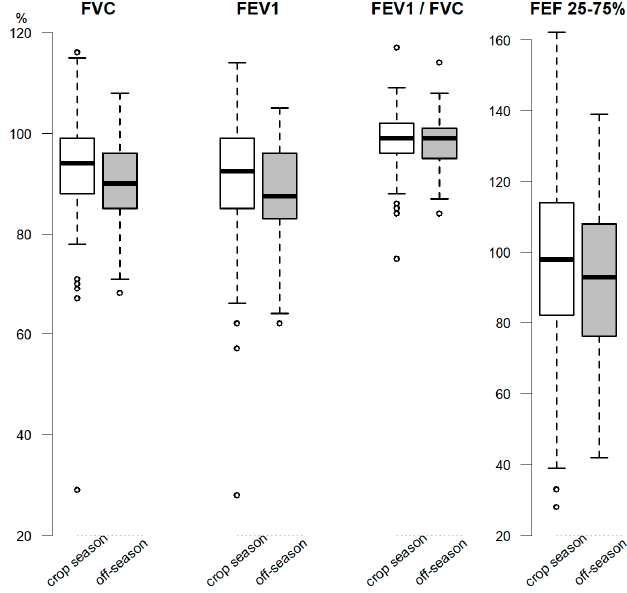
Figure 1. Boxplot of spirometry results comparison (in percentage of predicted) between crop season (2014) and off-season (2015) among family farmers in SJU. Notes: Light and dark boxes represent the crop season and off-season, respectively. The boxes show the interquartile range (IQR, 25th–75th percentile) and the horizontal line inside the box represents the median; the circles show the outlier values. FVC, FEV 1 and FEV 1 /FVC presented non-normal distribution while FEF 25–75% presented normal distribution.